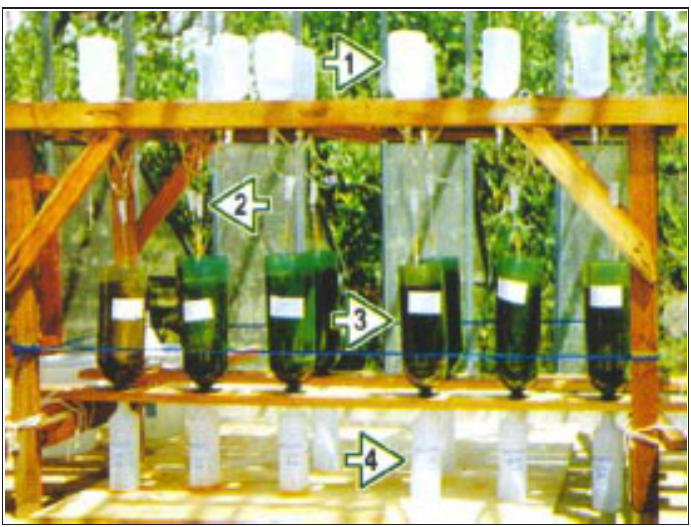
Figura 1. Aspecto do experimento para lixiviação de metais. (1) Frasco com solução percolante; (2) Mangueira com controle de vazão; (3) Tubo de percolação com os solos (testemunha e tratados com lodo); (4) Frasco coletor de lixiviado com capacidade para 500